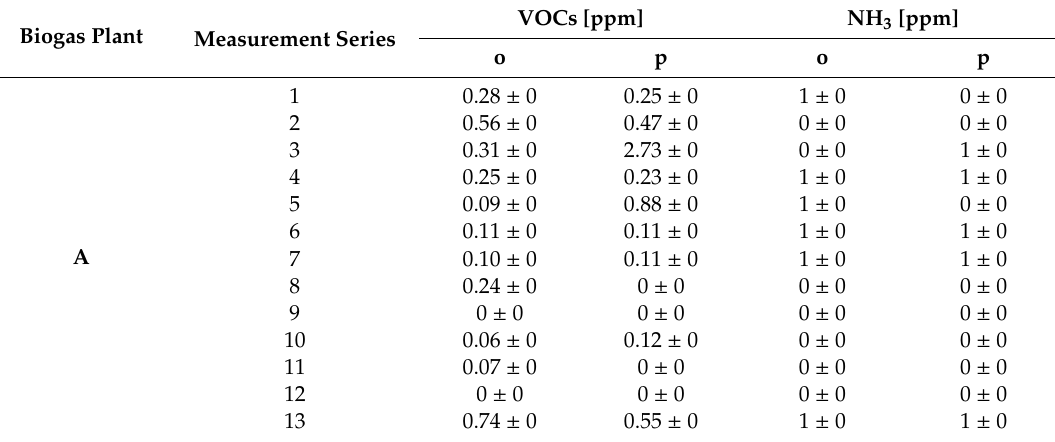
Table 8. Measurement results in front of the technological plant buildings. Biogas